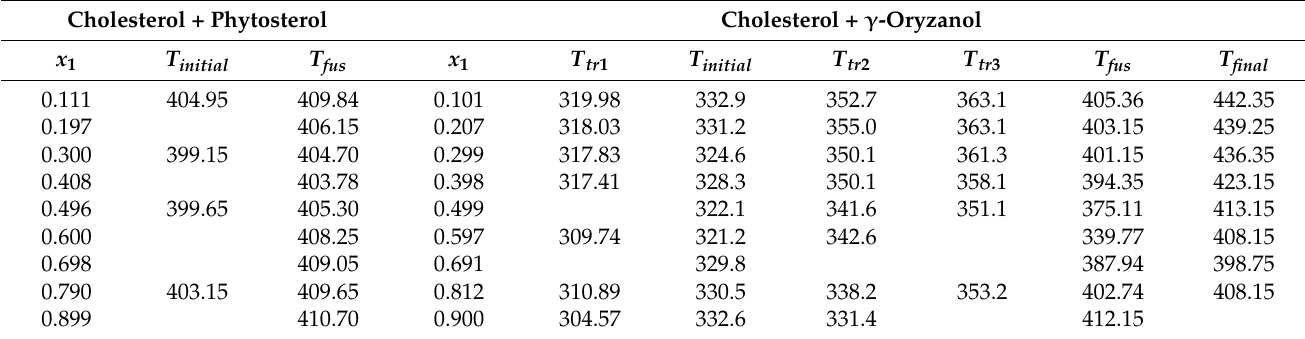
Table 1. SLE data (K) obtained by DSC and POM.